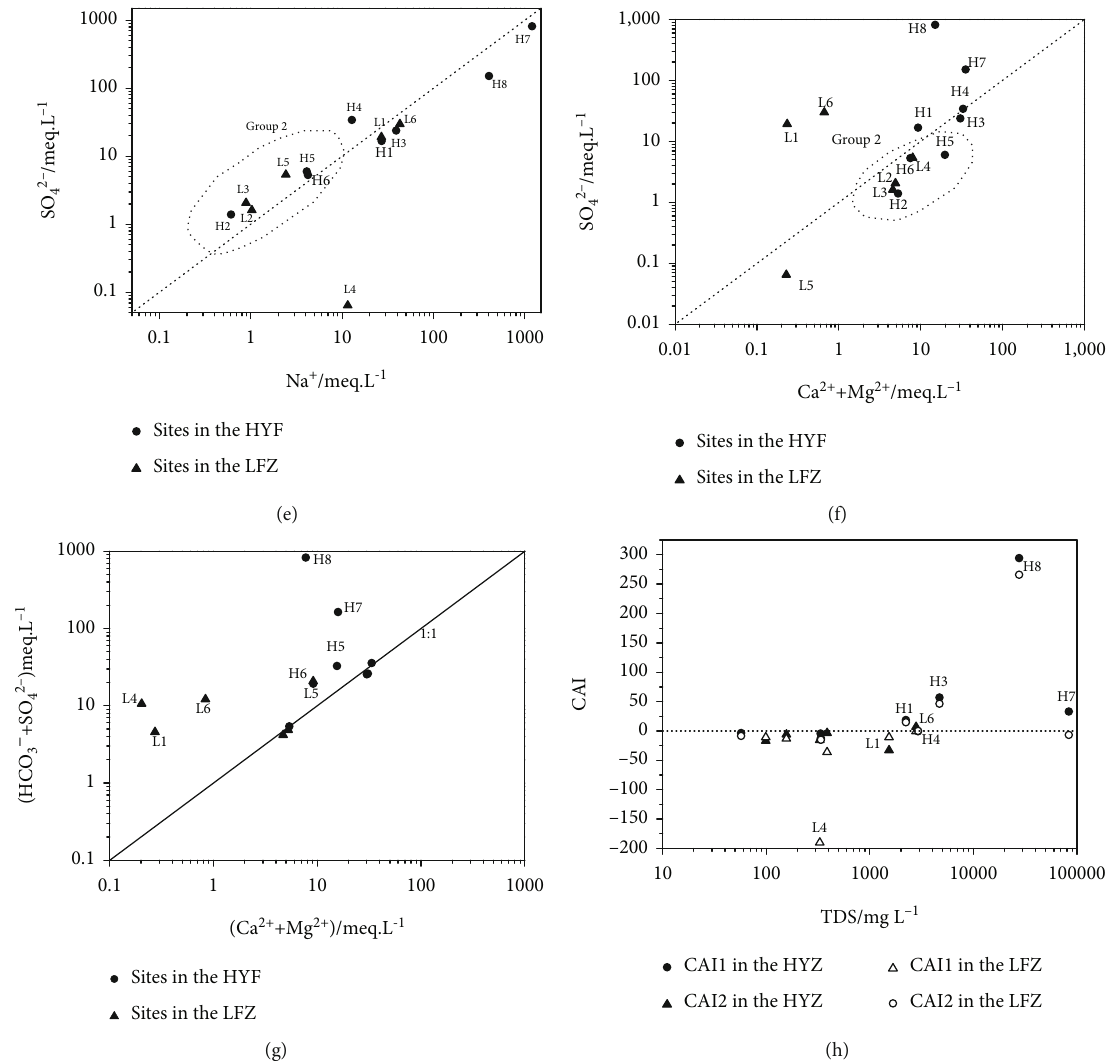
Figure 5: Proportion coe ffi cients of major ions in groundwater from the HFZ and LFZ zones for samples collected in the dry and rainy 1 : 1 line of Ca 2+ +Mg 2+ vs. HCO